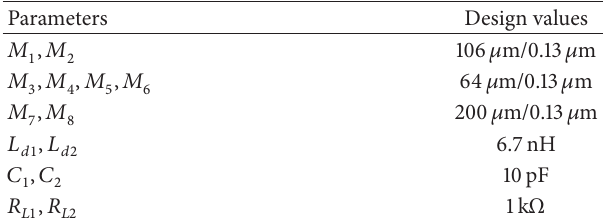
Table 1: Design parameters for the